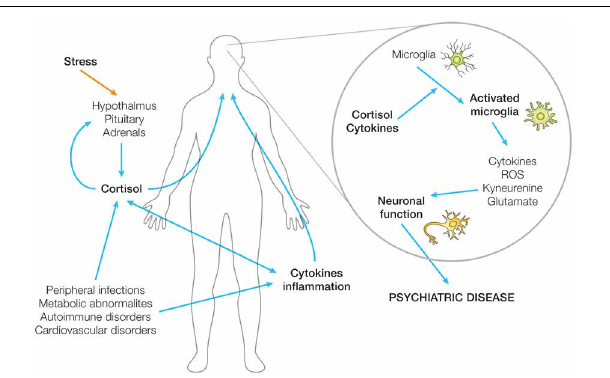
FIGURE 1 | Biological mechanisms by which peripheral dysfunction may impact on neuronal function and therefore psychiatric state. Schematic illustration of the potential role of the CNS inflammatory cells, microglia, as a critical nexus between HPA axis activity, inflammation, and neuronal